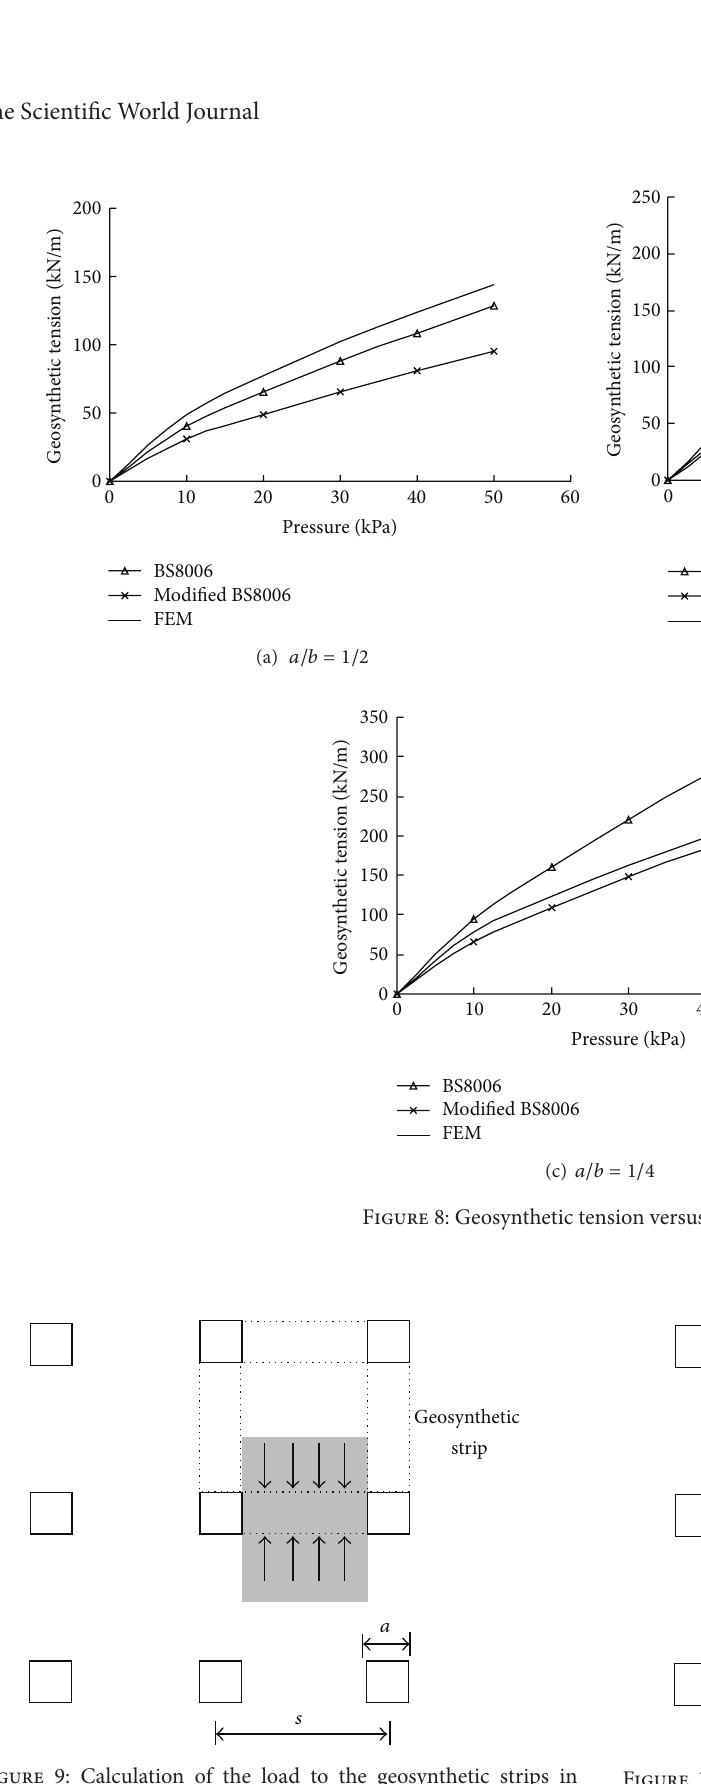
Figure 10: Calculation of the load to the geosynthetic strips in modified BS8006 (after